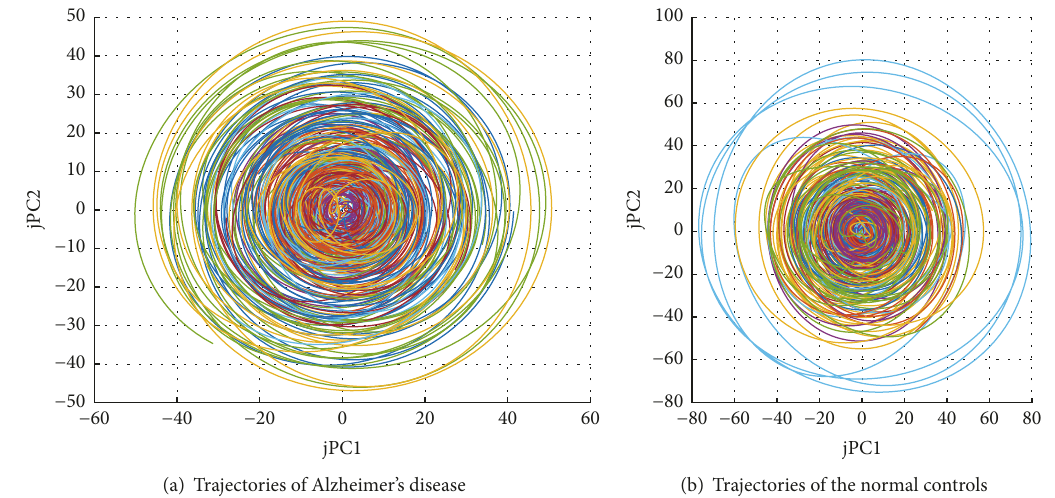
Figure 7: Trajectories at band slow 4 of (a) the AD group and (b) the NC group (one color represents one person; all trajectories were obtained with cubic spline